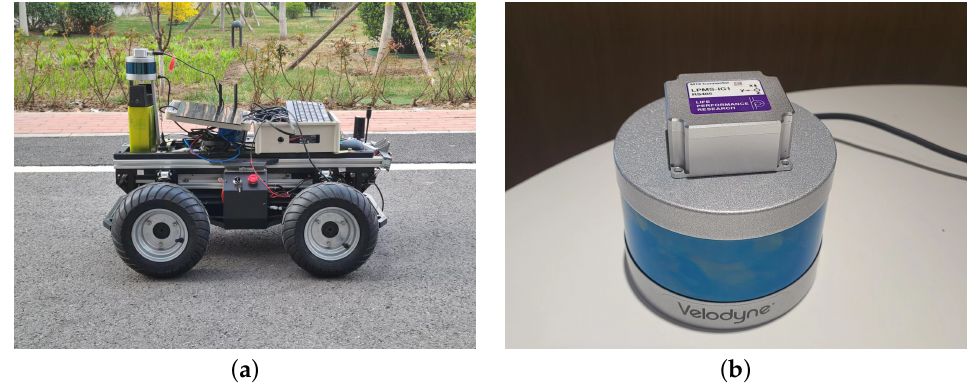
Figure 4. The experiment platform. Our dataset is collected on automated guided vehicle ( a ) using sensor component ( b